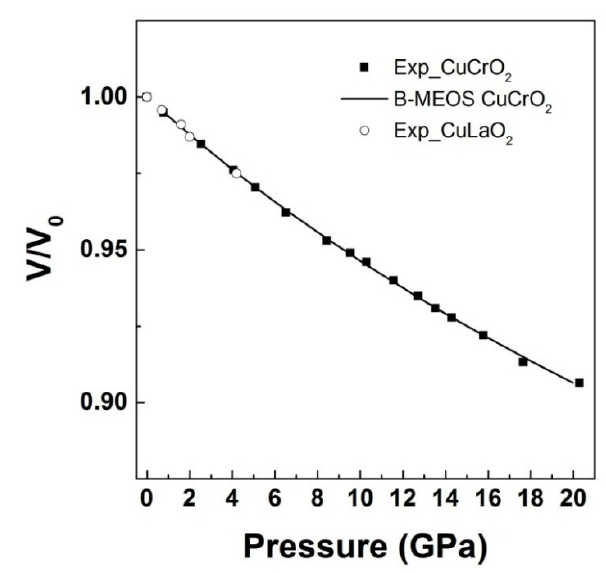
Figure 10. Normalized pressure–volume data for CuCrO 2 and CuLaO 2 . Symbols are explained in the figure.